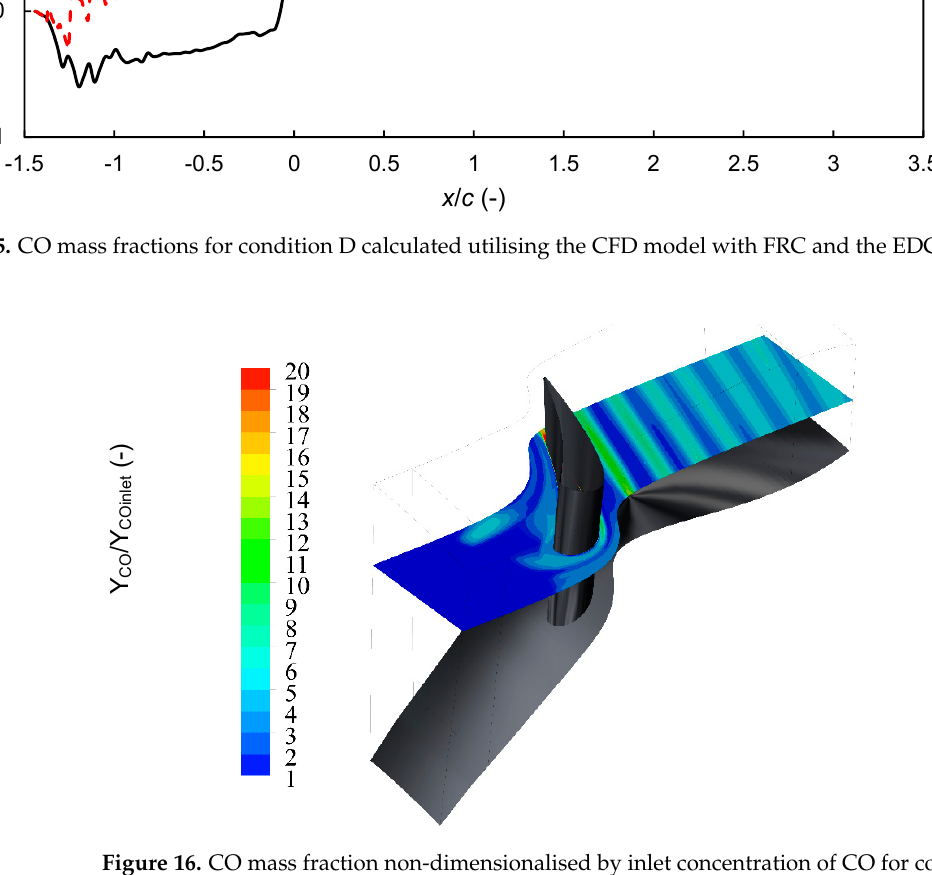
Figure 16. CO mass fraction non-dimensionalised by inlet concentration of CO for condition D with the EDC approach and the POLIMI H 2 CO mechanism. The highest values on the scale can be seen at the blade boundary